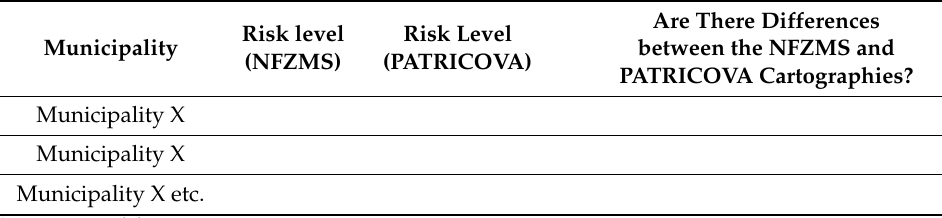
Figure 9. Local-scale. Image capture of the risk layers of the NFZMS (flood risk; return period 500 years) and the PATRICOVA viewer (city of Orihuela; Segura River). Note: the red box corresponds to where the main differences are located at the local scale Source: Ministry for the Ecological Transition and Demographic Challenge [48]; Valencian Cartographic Institute [53]. Own elaboration. Table 6. The table shows the municipal information related to flood risk.